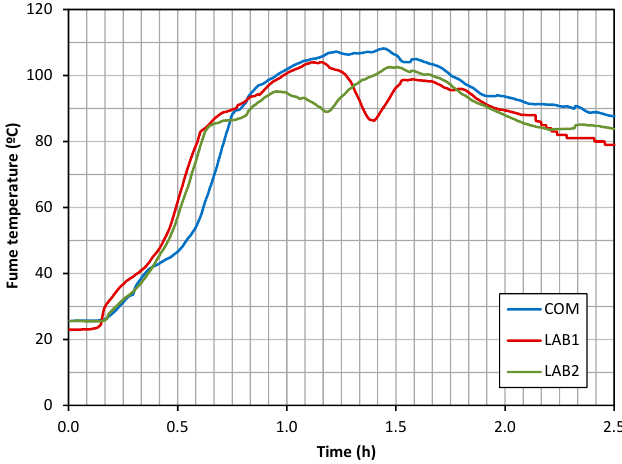
Figure 12. Fume temperature during combustion tests.